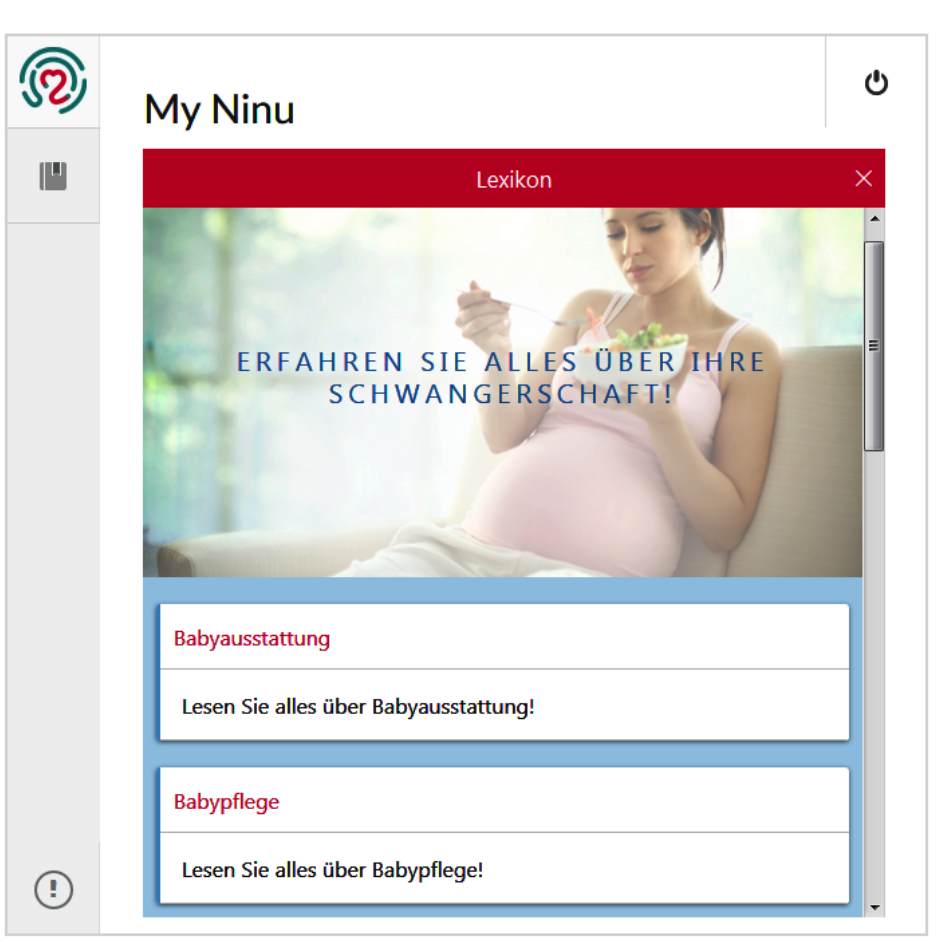
Figure 2. Patient education application